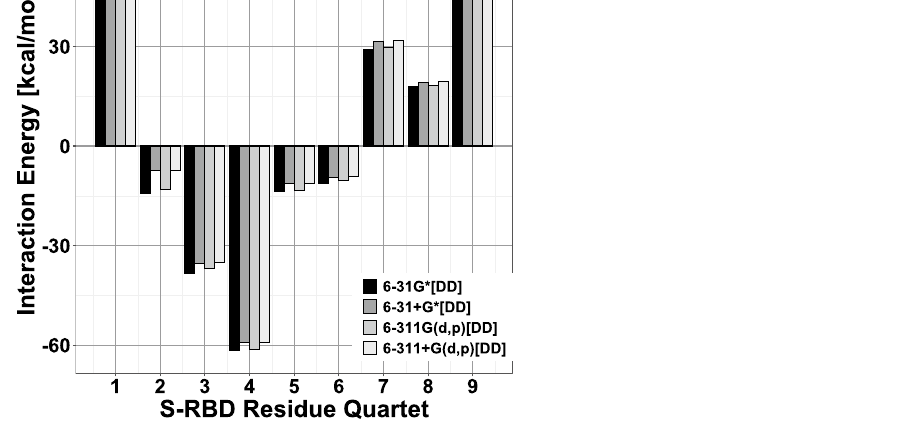
Figure 5. Interaction energies between SARS-CoV-2 S-RBD quartets and neighboring hACE2 residues. Interactions of repulsive (positive) and attractive (negative) character [kcal/mol] between SARS-CoV-2 quartets and hACE2 residues within a 4.5 Å radius. For each quartet four adjacent vertical bars are shown corresponding to density functional calculations with 6-31G*, 6-31+G*, 6-311G(d,p) and 6-311+G(d,p) basis sets, respectively, plus additional van der Waals dispersion [DD] 22 corrections. Results from different basis sets are qualitatively similar. Quartet and supermolecular fragment coordinates used in calculations taken from PDB entry